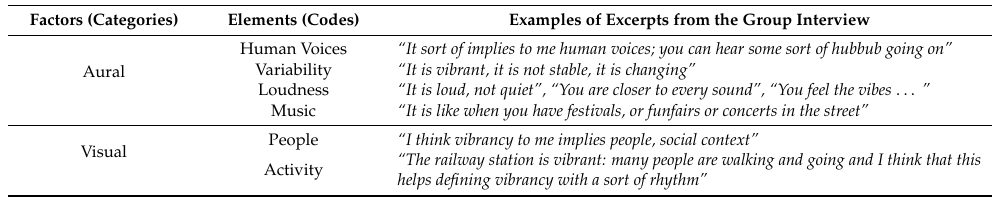
Table 3. Main elements contributing to the vibrancy of an urban environment, as coded in the group